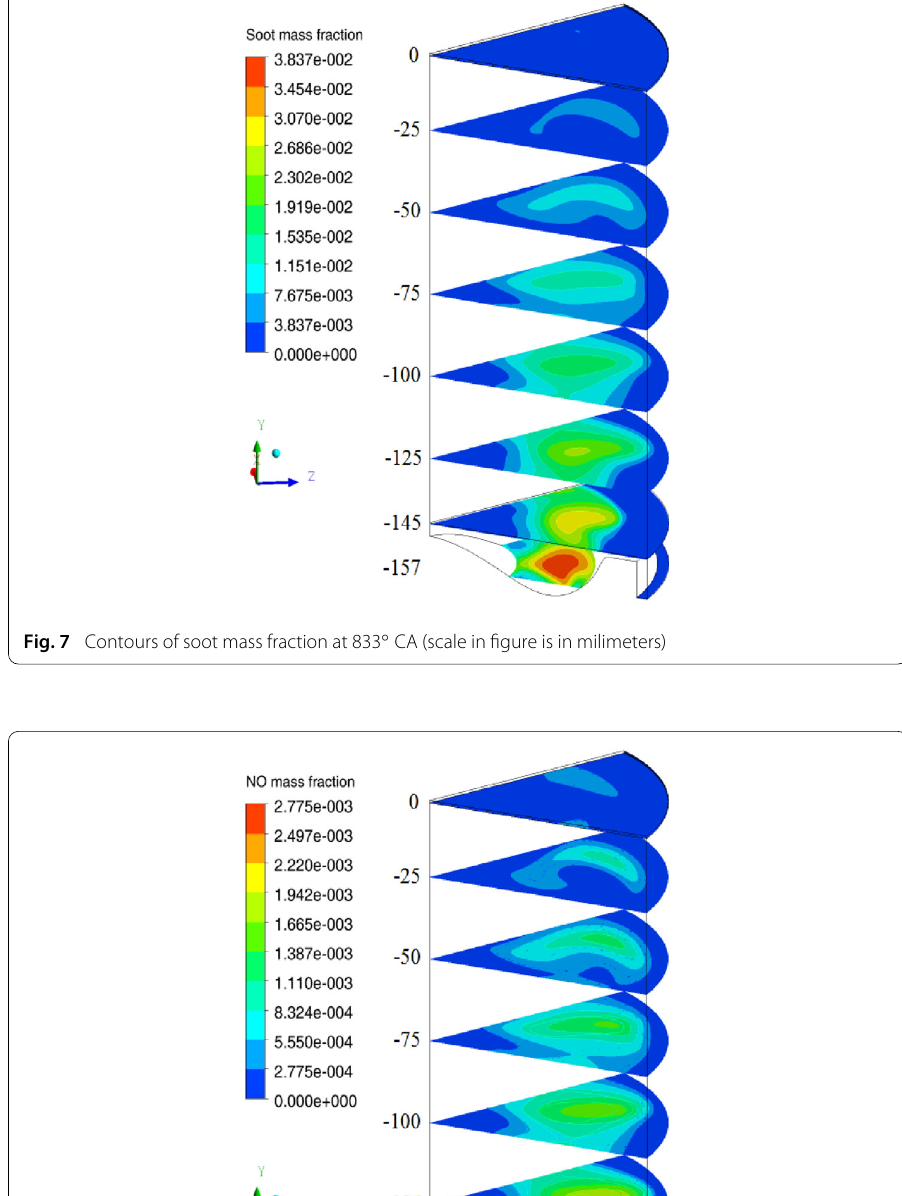
present design, the fuel is sprayed in the piston bowl and most of the air–fuel mixture lies in the piston bowl and travels with the piston. Moreover, post-combustion production of soots also takes place in the piston